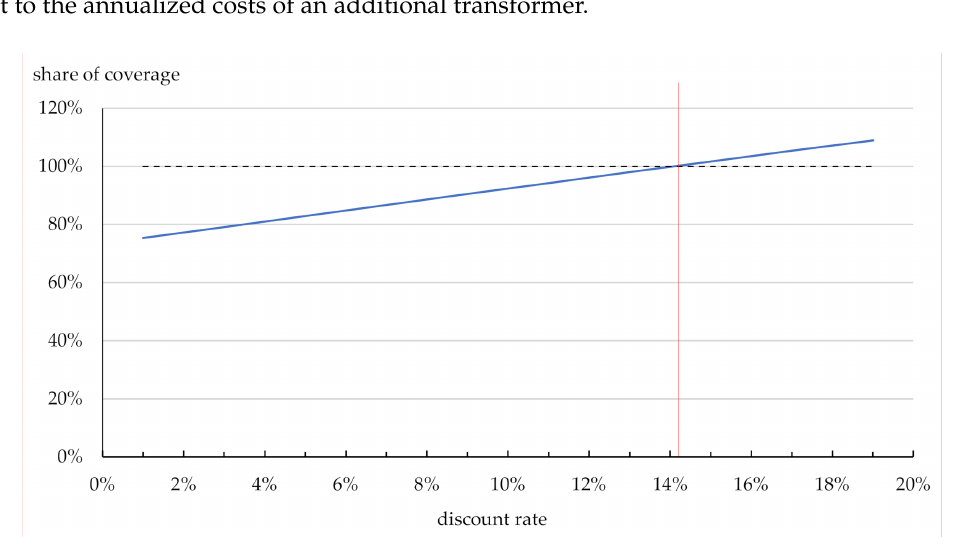
Figure 14. Share of coverage of annualized costs of additional